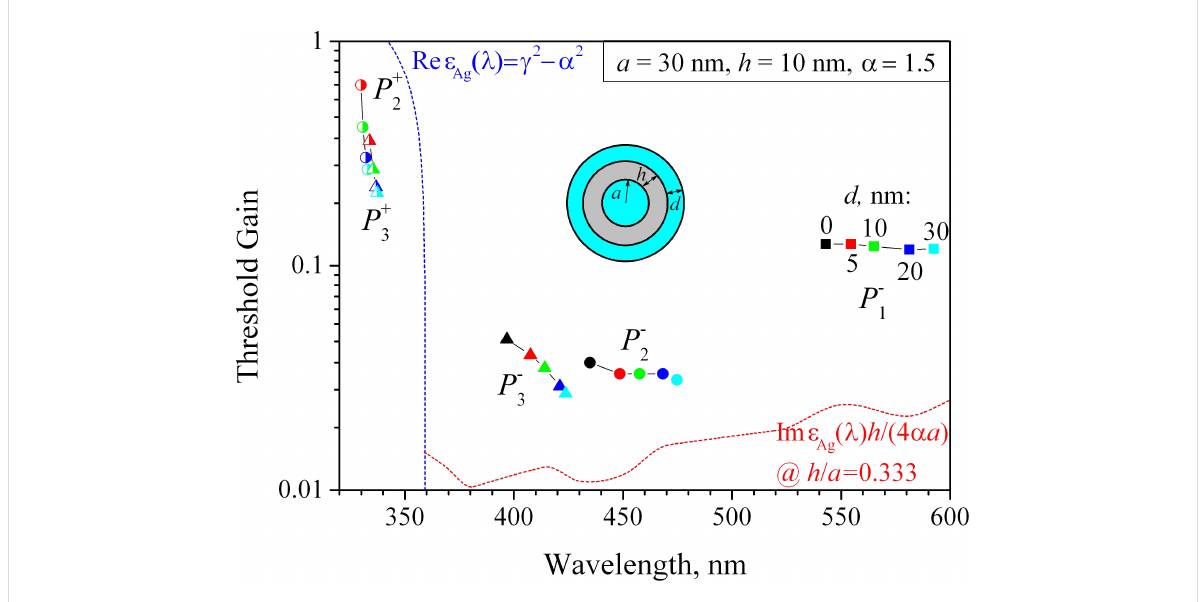
Figure 7: The trajectories of the eigenvalues of lasing modes on the plane ( λ , γ ) for a plasmonic silver nanotube laser with active core radius a = 30 nm and tube thickness h = 10 nm. The active shell thickness varies from 0 to 30 nm as marked on the trajectories. The dashed curves are the same as in Figure 5 and Figure